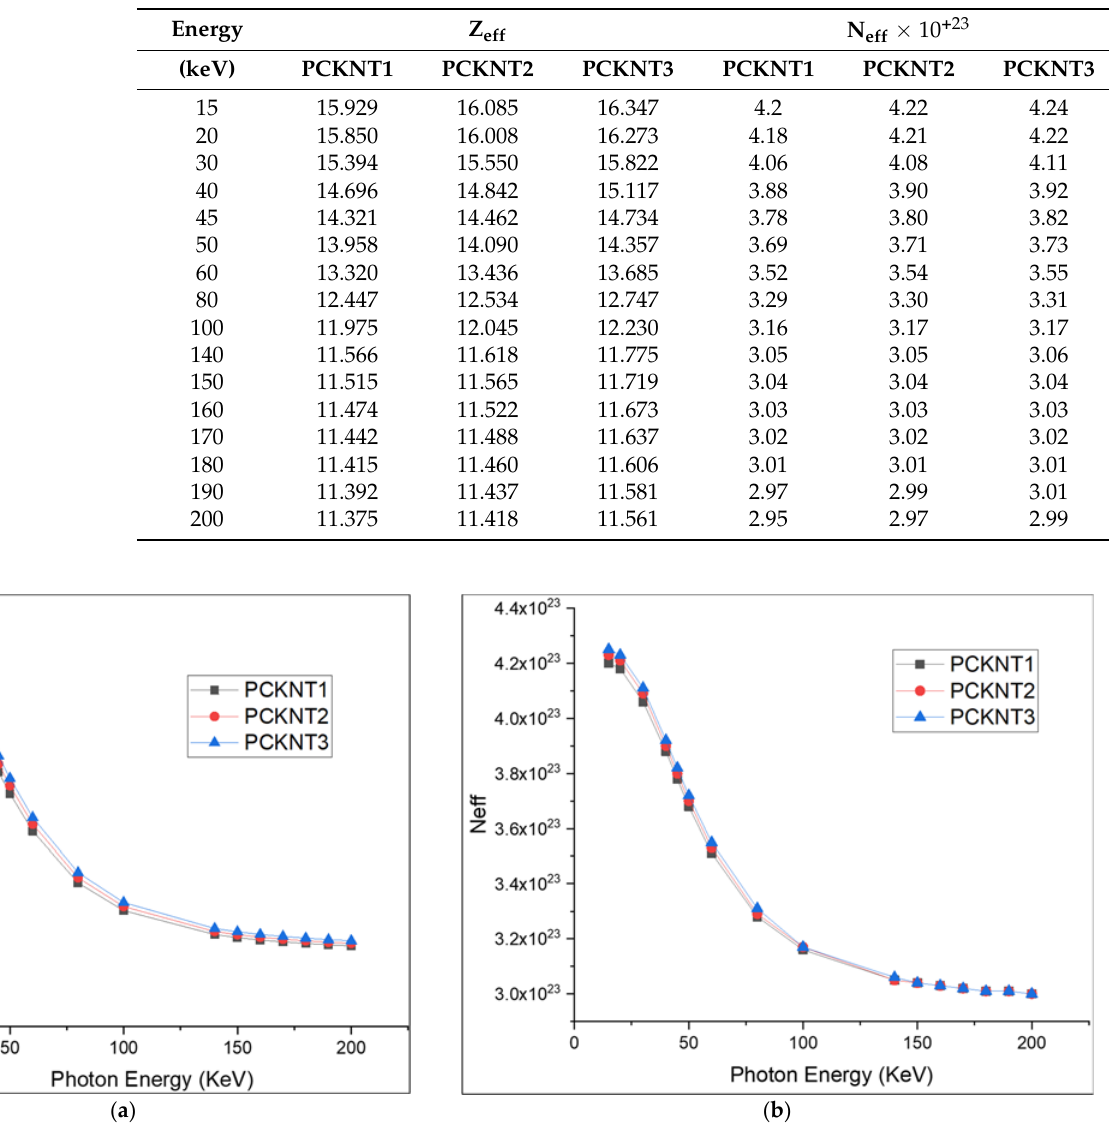
Figure 8. The radiation shielding parameters: ( a ) effective atomic number (Z eff ); ( b ) effective electron number (N eff ). Table 6. Effective atomic number and effective electron density for PCKNT glasses.